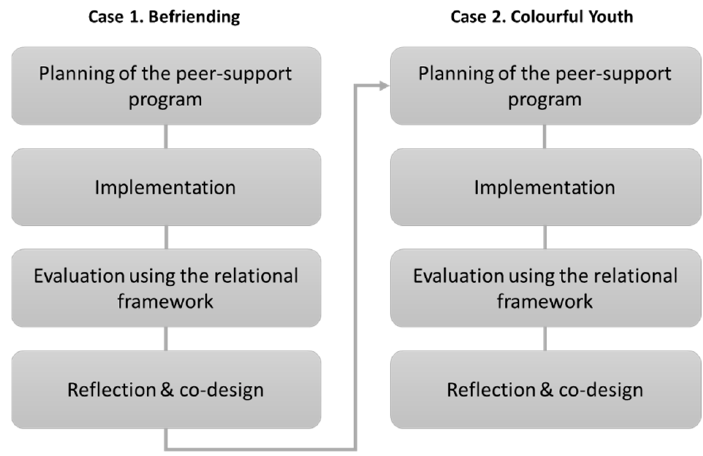
Figure 3. The case study process.